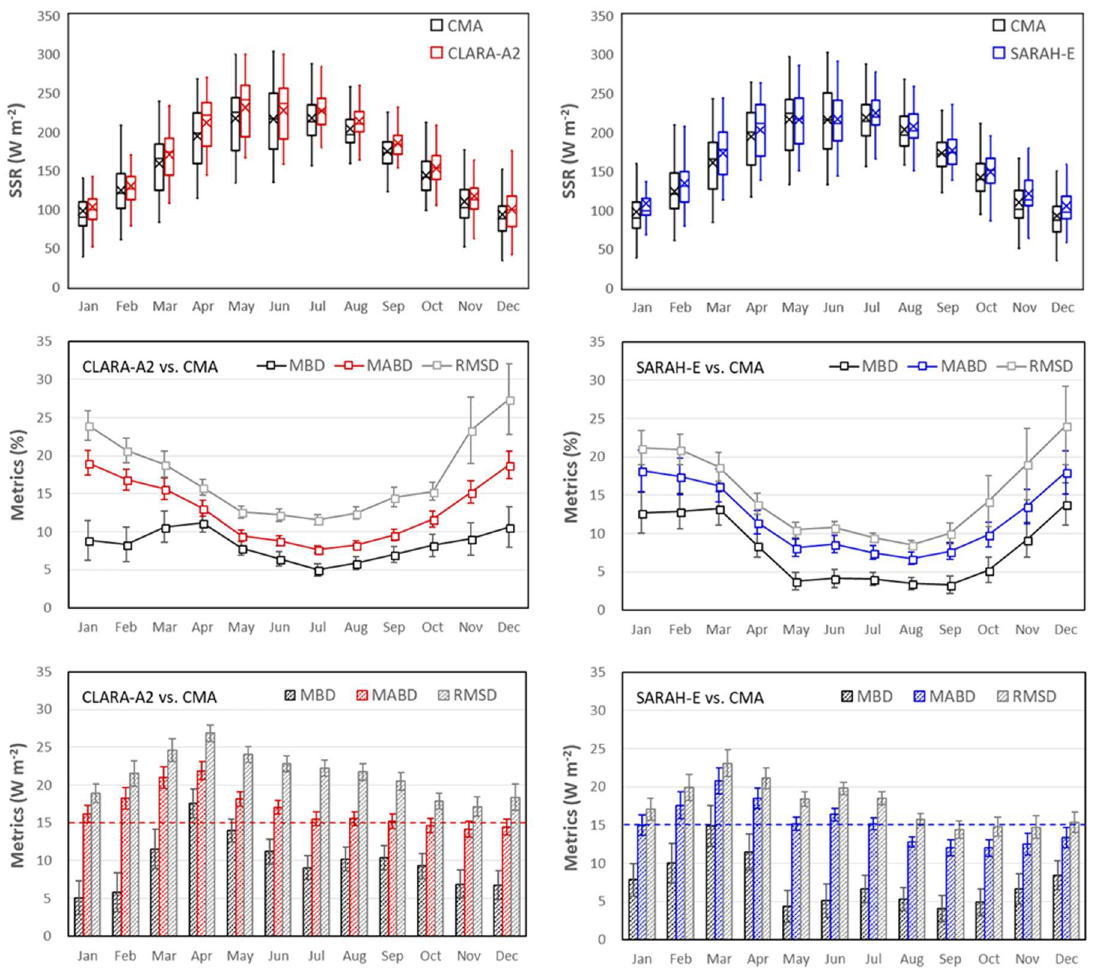
Figure 4. Comparisons of the multiyear-averaged monthly mean SSR (Surface Solar Radiation, W m − 2 ) of CLARA-A2/SARAH-E estimates against the corresponding surface observations and the metrics of MBD (Mean Bias Deviation), MABD (Mean Absolute Bias Deviation) and RMSD (Root Mean Square Deviation) in both W m − 2 and %. For the box plots shown in the upper panels, the first, second and third lines of the box represents the first, second and third quartiles, respectively; cross marks denote the means; the whiskers indicate the standard errors of the means.